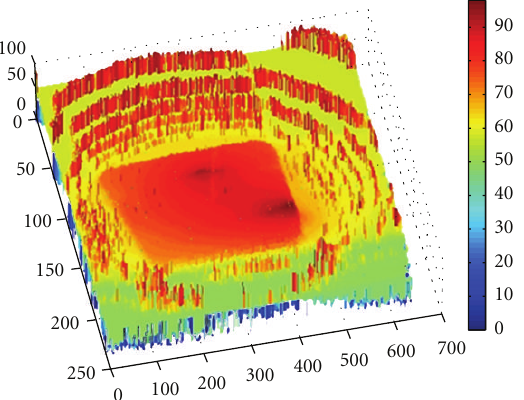
Figure 6: 3D temperature plot of IR data extracted from the back of the cell of Figure